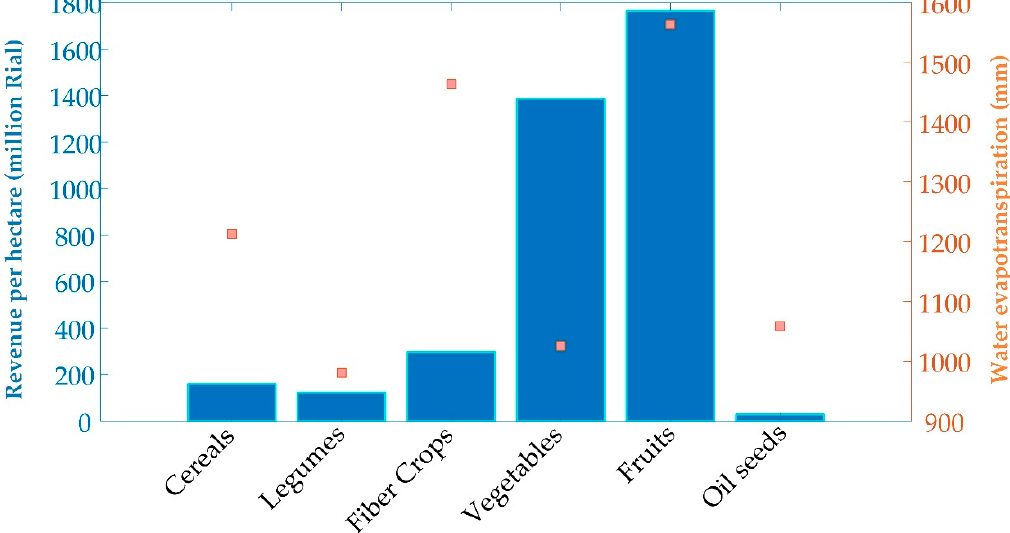
Figure 6. 10-year average of South Khorasan crop revenue per hectare and crop water requirement.